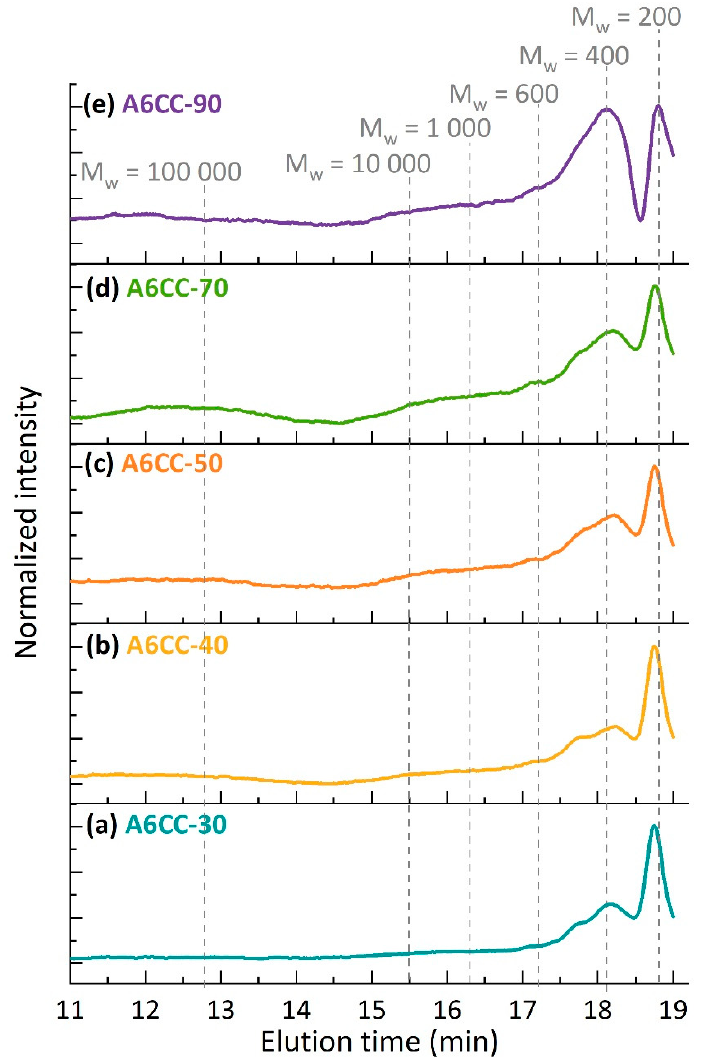
Figure 6. GPC chromatograms of the of the series of A6CC samples in chloroform: ( a ) A6CC-30, ( b ) A6CC-40, ( c ) A6CC-50, ( d ) A6CC-70 and ( e ) A6CC-90. For reference, dashed lines indicate the weight average molecular weights of the polystyrene calibration curve.